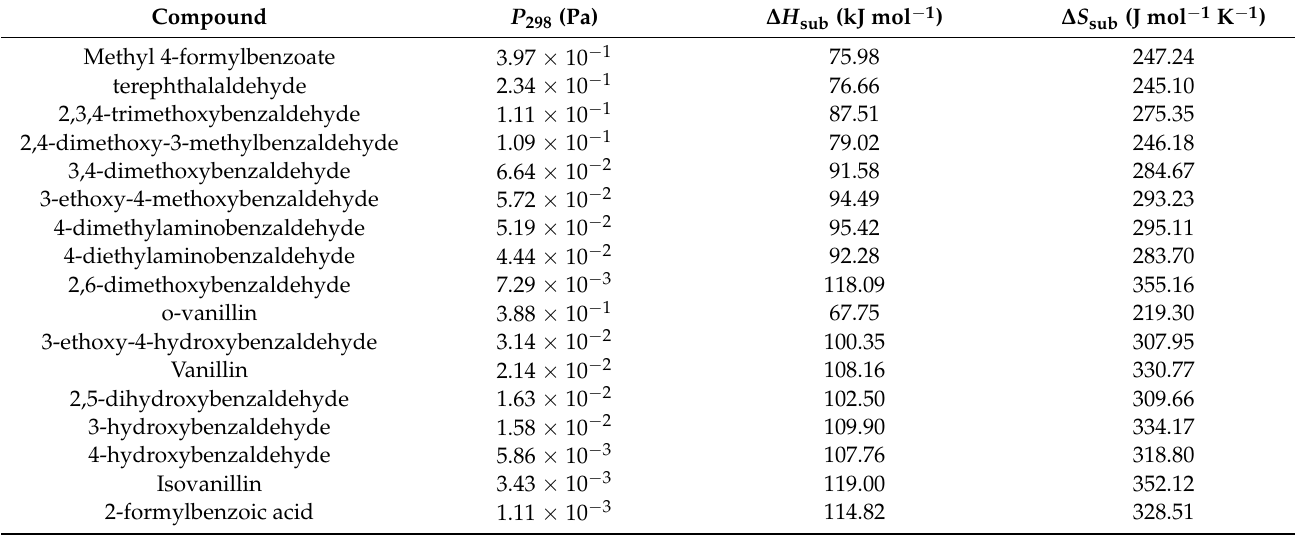
Table 2. P sat at 298 K, and enthalpies and entropies of sublimation of benzaldehydes determined using KEMS. The S compounds below the dashed line are capable of H-bonding in the pure component and those above the dashed line are not. Compound P 298 (Pa) ∆ H sub (kJ mol − 1 ) Methyl